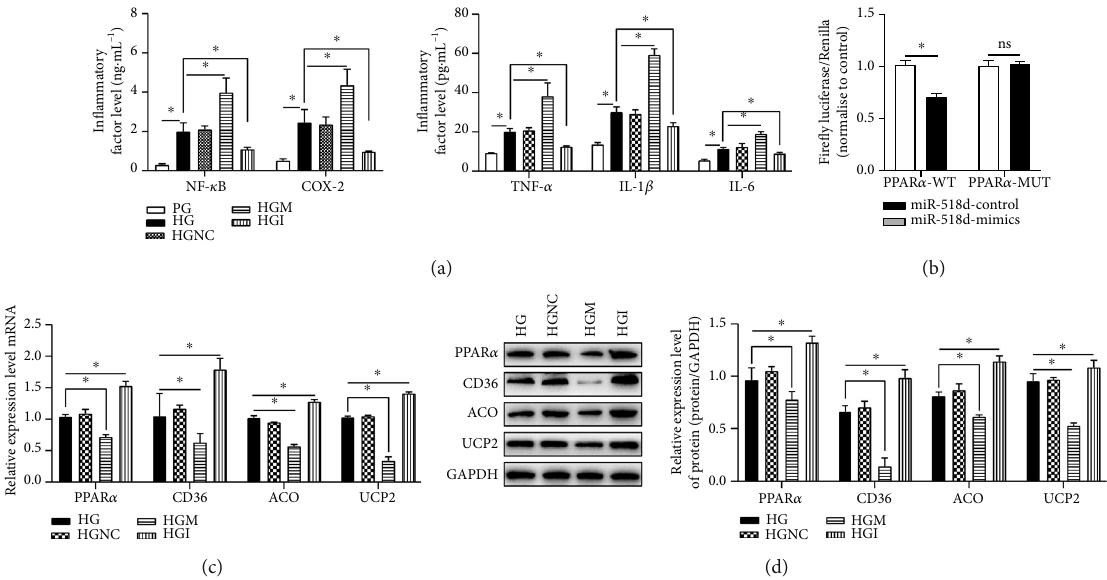
Figure 2: miR-518d a ff ects the in fl ammatory responses in HTR8/SVneo cells. (a) Levels of relative in fl ammatory factors (NF- κ B, TNF- α , IL-1 β , IL-6, and COX-2) in HTR8/SVneo cells cultured at various conditions detected by ELISA. (b) Validation of the correlation between miR-518d and PPAR α detected by the DLR assay. Expression levels of PPAR α and its downstream genes (CD36, ACO, and UCP2) examined by (c) RT-PCR and (d) Western blotting. All data were represented as mean ± SD . ∗ p < 0 : 05 .